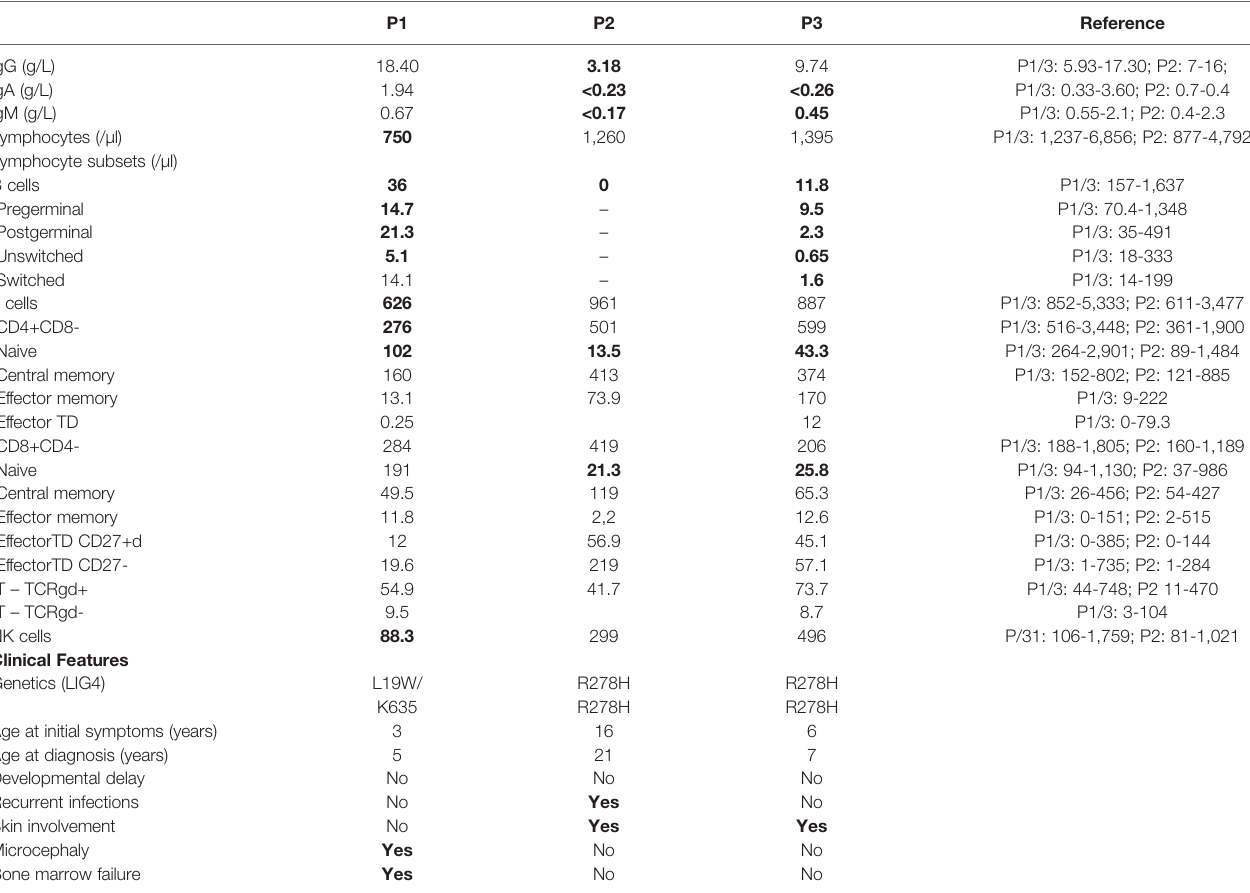
Bold text signify values outside the reference